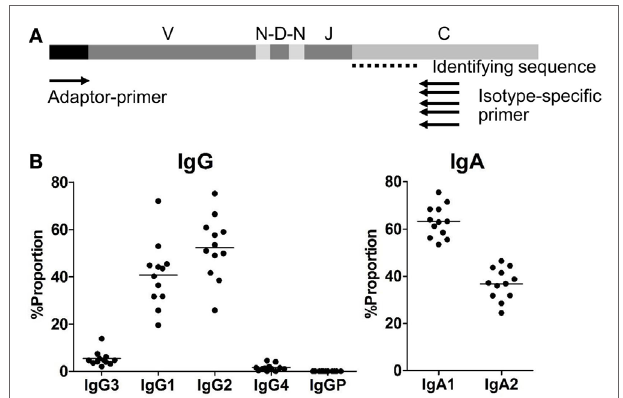
FigUre 1 | (a) Adaptor-ligation PCR for next-generation sequencing-based antibody repertoire analysis. A universal primer specific for the isotype constant region (isotype-specific primer) and an adaptor primer were used for unbiased amplification of antibody genes. IgM-, IgD-, IgG-, IgA-, and IgE-specific primers were used for amplification of respective isotype genes. Amplified gene products were sequenced using an Illumina MiSeq sequencer, and each sequence read was classified into immunoglobulin subclasses by discrimination using the identifying sequence of the constant region. (B) Proportions of IgG and IgA subclasses in healthy individuals. Proportions of sequence reads of IgG subclasses (IgG3, IgG1, IgG2, IgG4, and IgGP) and IgA subclasses (IgA1 and IgA2) are indicated. Total sequence reads excluding unproductive reads (out-of-frame reads) were used for calculation. Each dot represents an individual and bars indicate mean frequencies ( n =